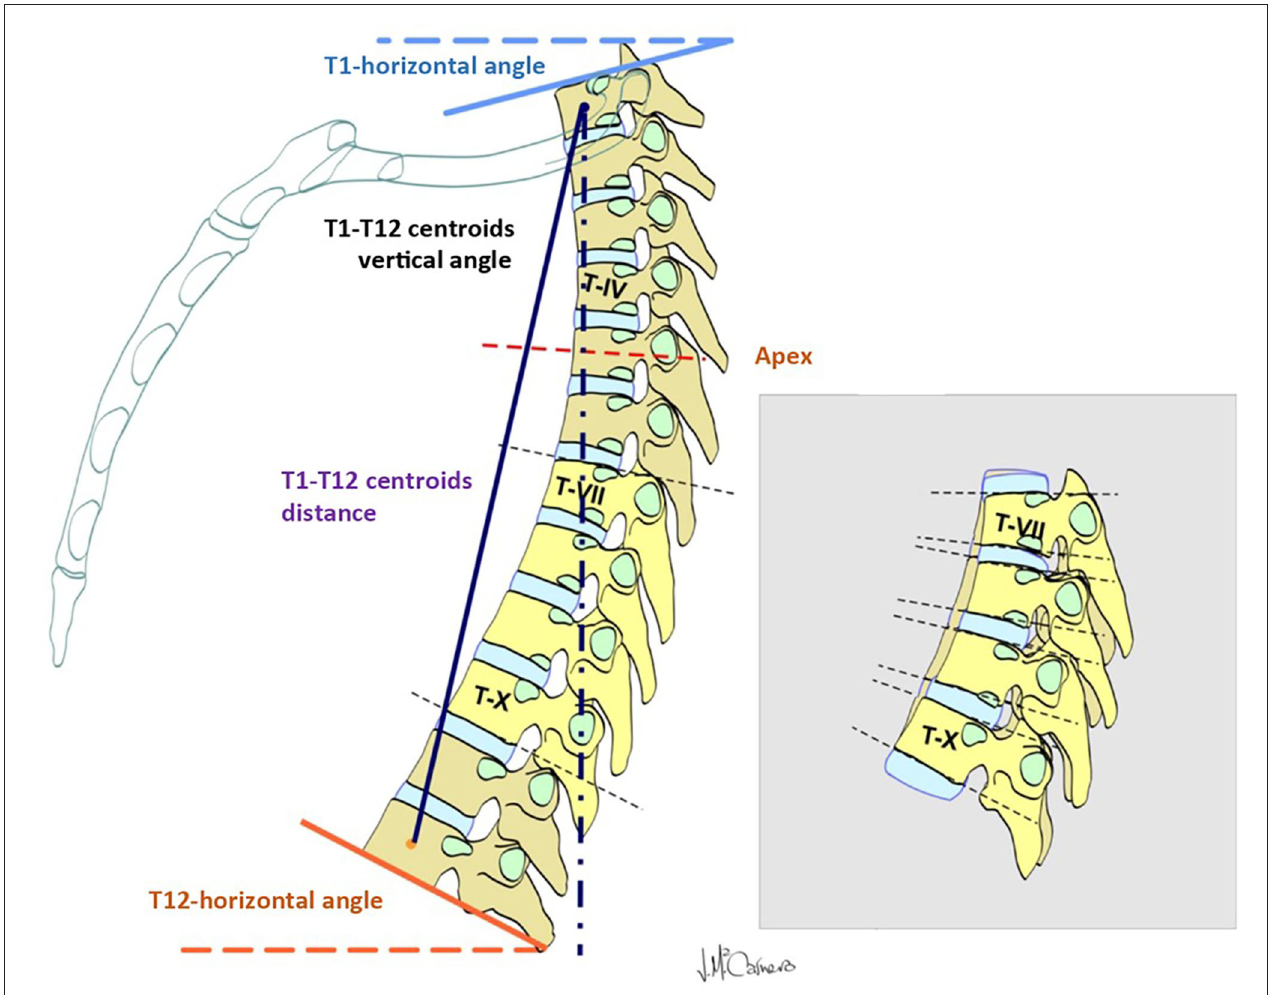
FIGURE 1 | Parameters measured to evaluate the mobility of the thoracic